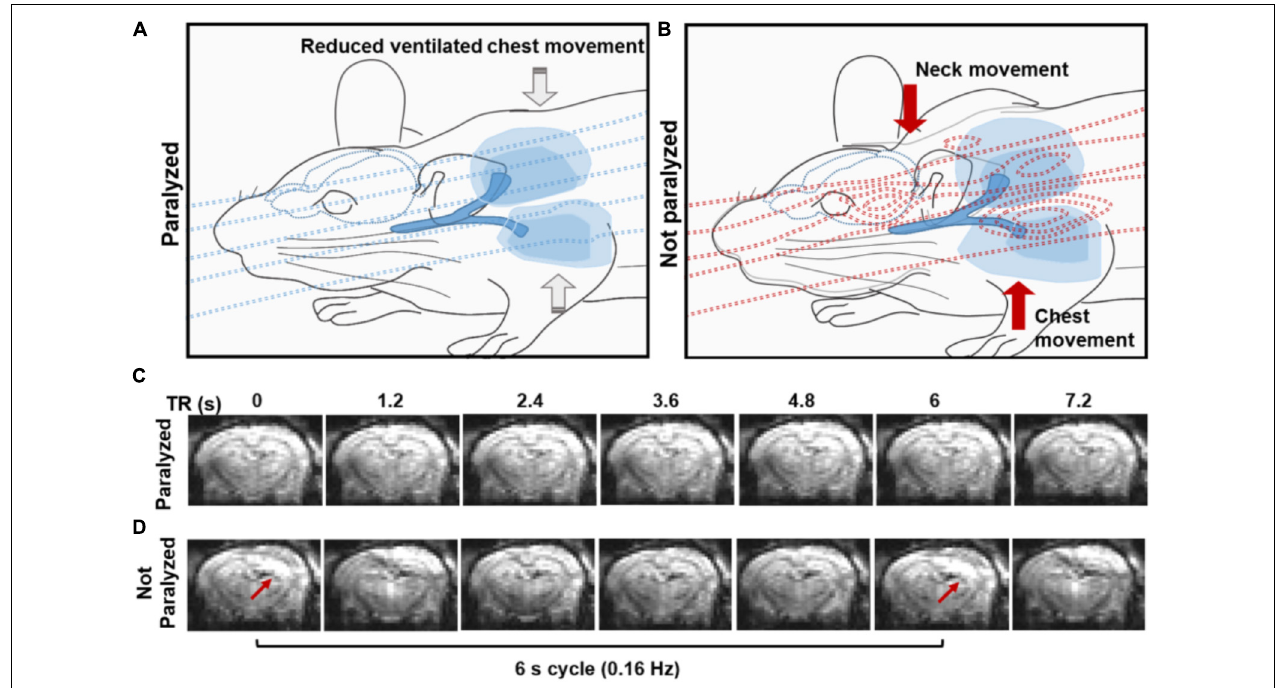
FIGURE 1 | Effect of the spontaneous respiration on the B0 field. (A,B) The schemes illustrate the B0 field at the iso-center of the MR bore in the presence of a paralyzed (A) or a non-paralyzed animal (B) . Note how the B0 is relatively homogeneous when a paralyzed animal is passively ventilated due to the lack of large body motion and how B0 inhomogeneities emerge upon active breathing involving diaphragm, intercostal and neck muscle movement during the respiration (B) . (C,D) Coronal sections from a 3D EPI sequence acquired at 1.2 s TR, showing the effect of the B0 (in)homogeneity in a paralyzed (C) and spontaneously breathing animal (D) . Note the distortions in the images acquired from the non-paralyzed animal, compared to the paralyzed